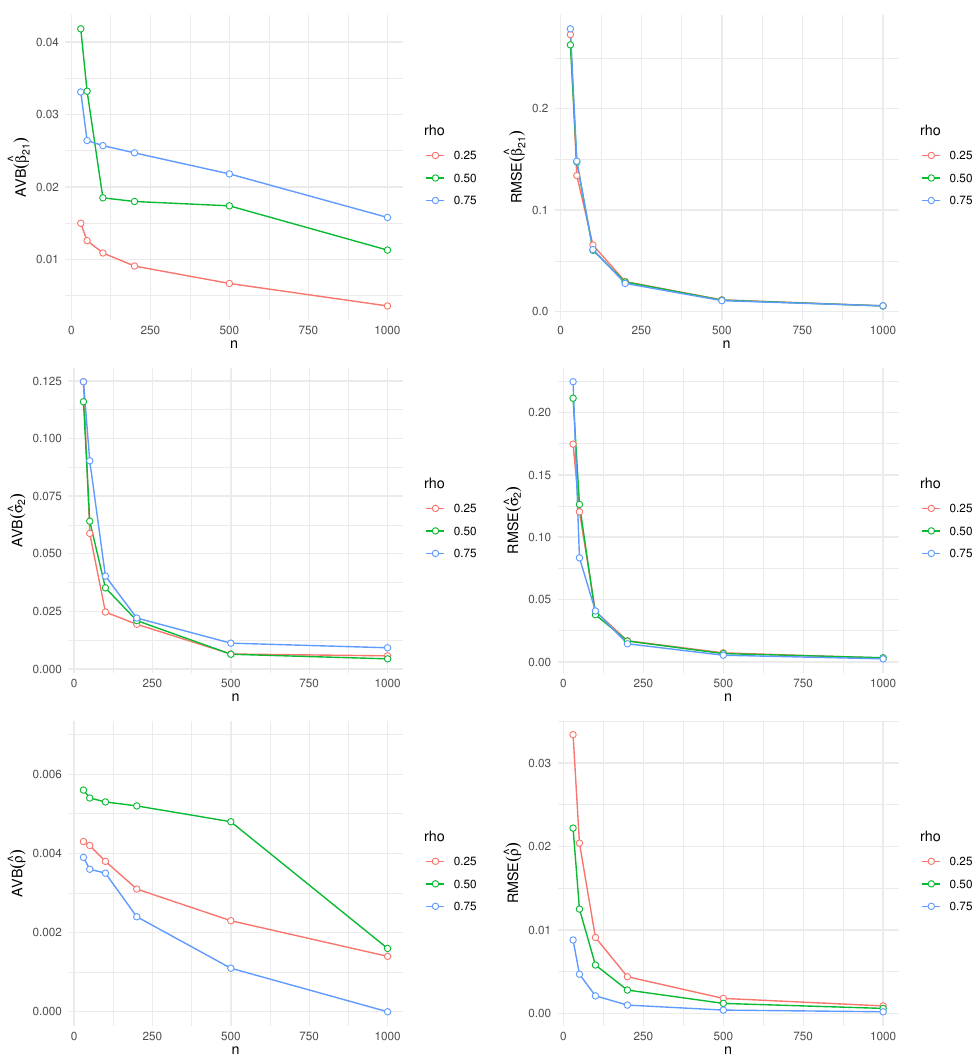
Figure 1. Asymptotic behavior of the MLE for the BVSHN regression model for scenario 1.